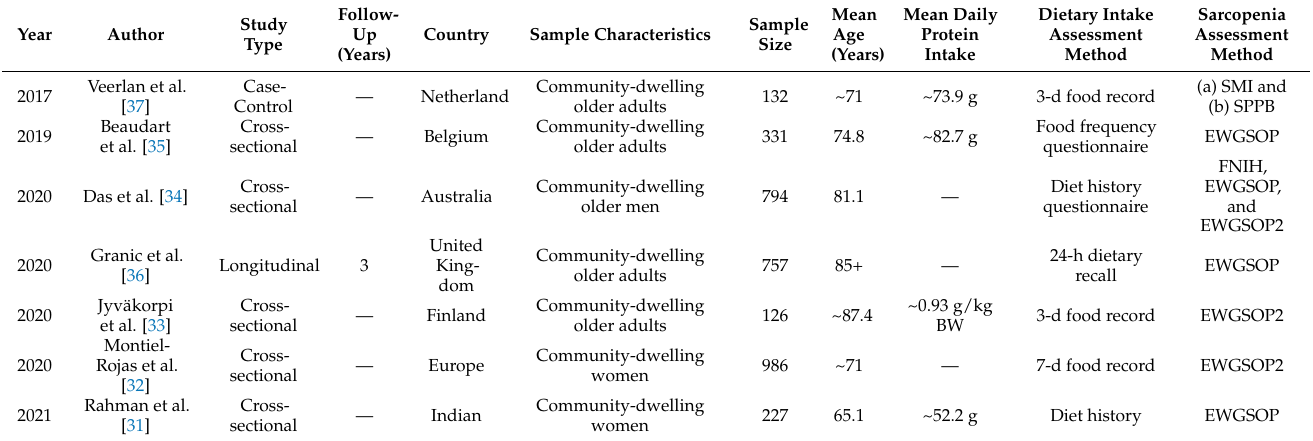
Figure 1. Flowchart of the study. Table 1. Characteristics of the included